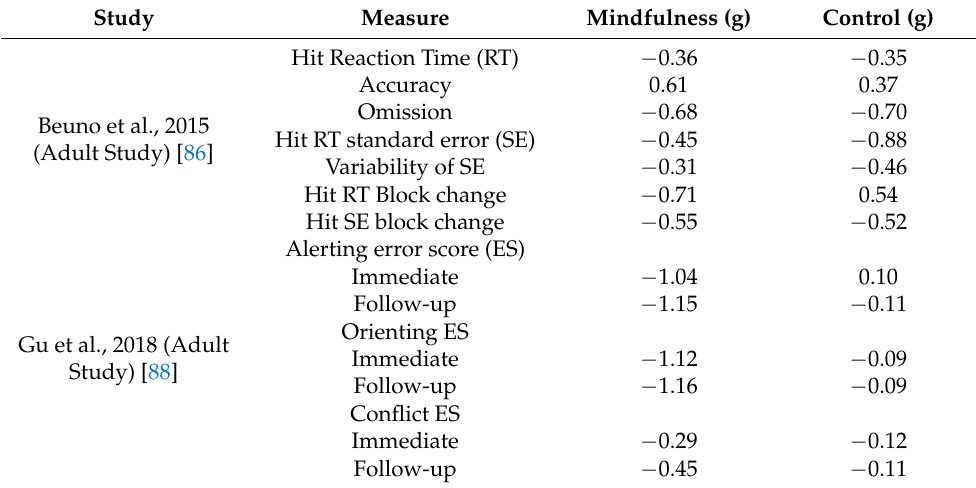
Table 2. Effect sizes for additional Attention Network Test (ANT) variables in adult studies.